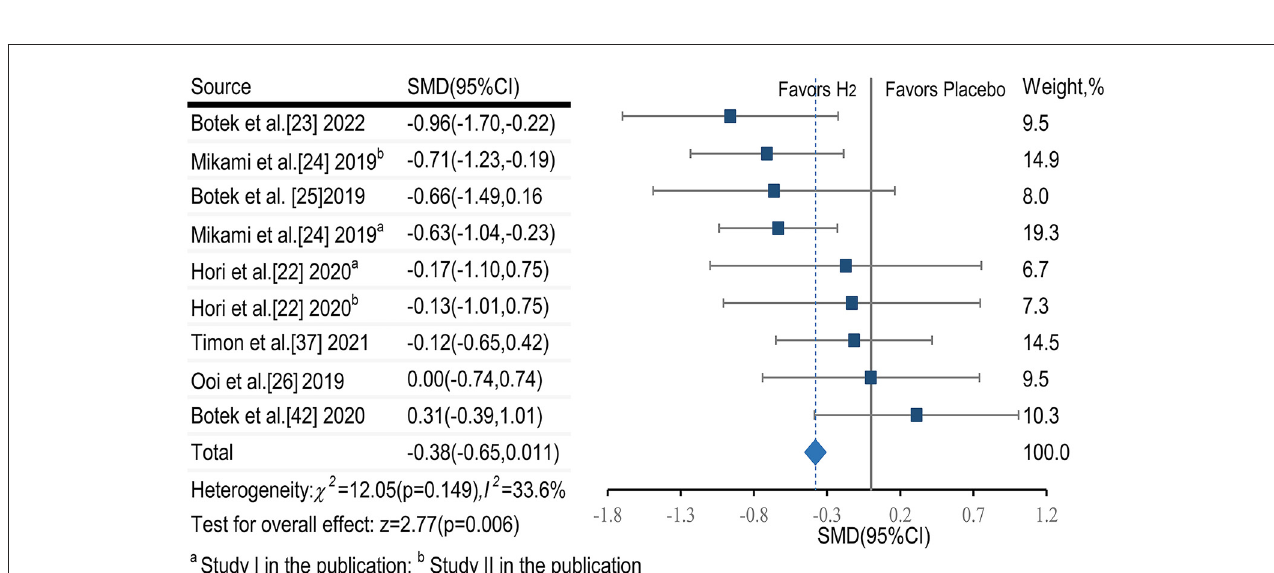
FIGURE3 The pooled effect size of H 2 intake on rating of perceived exertion.